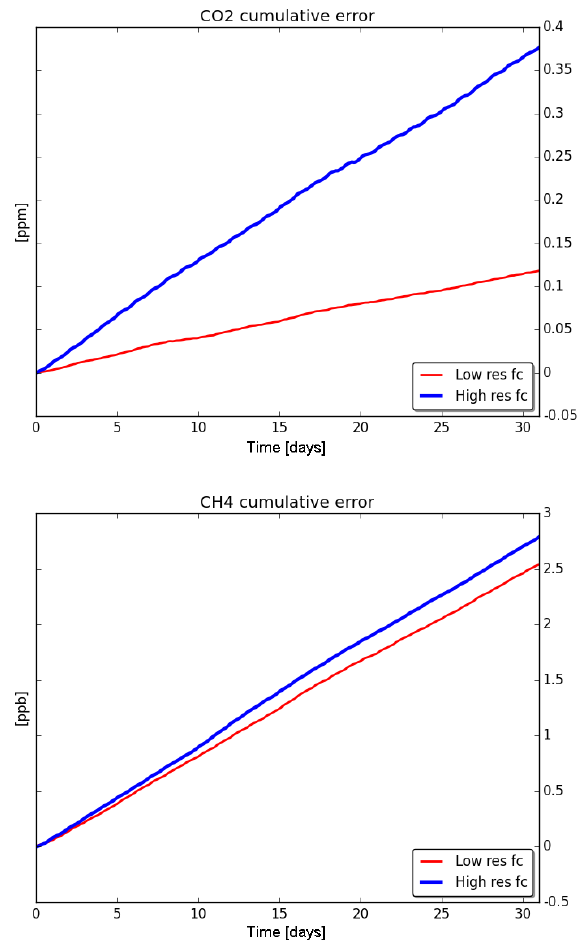
Figure 2. Cumulative global mean mass conservation error for CO 2 (ppm) and CH 4 (ppb) from 1 to 31 March 2013. Low- and high- resolution experiments are depicted by red and blue lines respec-